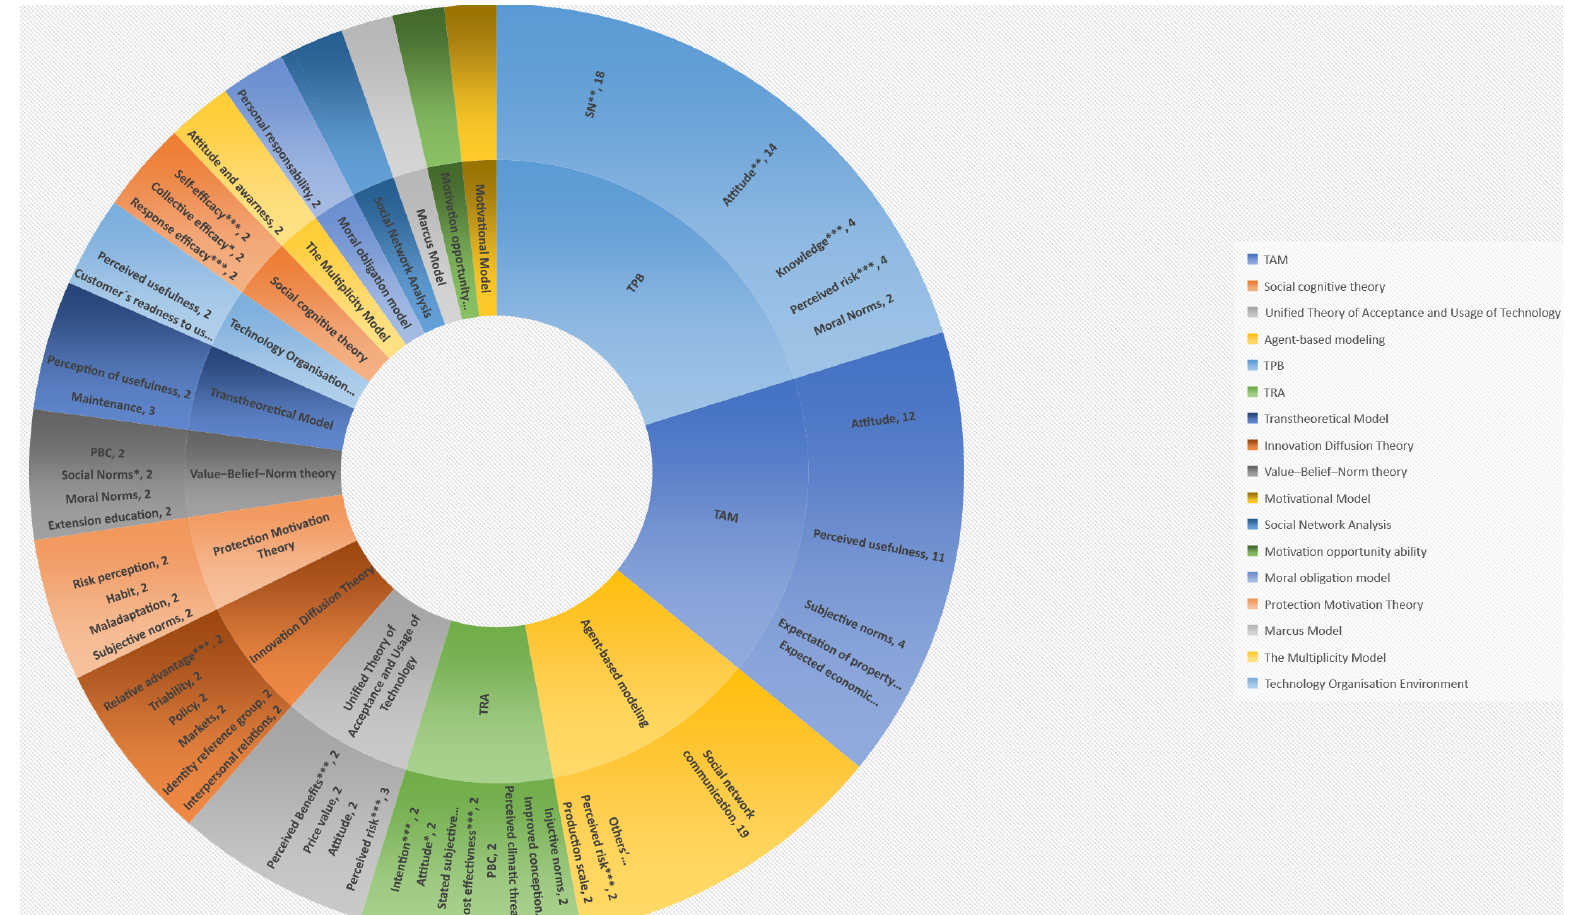
Figure 5. Sociopsychological models and respective constructs in the reviewed studies. Note: The level of the circle closest to the center includes the names of the models; in the next level, the constructs are represented, where the size of the area of different colors represents the frequency of those constructs in the reviewed studies, while the numbers in the figure are the vote-count results after analyzing the papers individually. * Critical level of significance of constructs at 10%, **: 5%, ***: 1%.